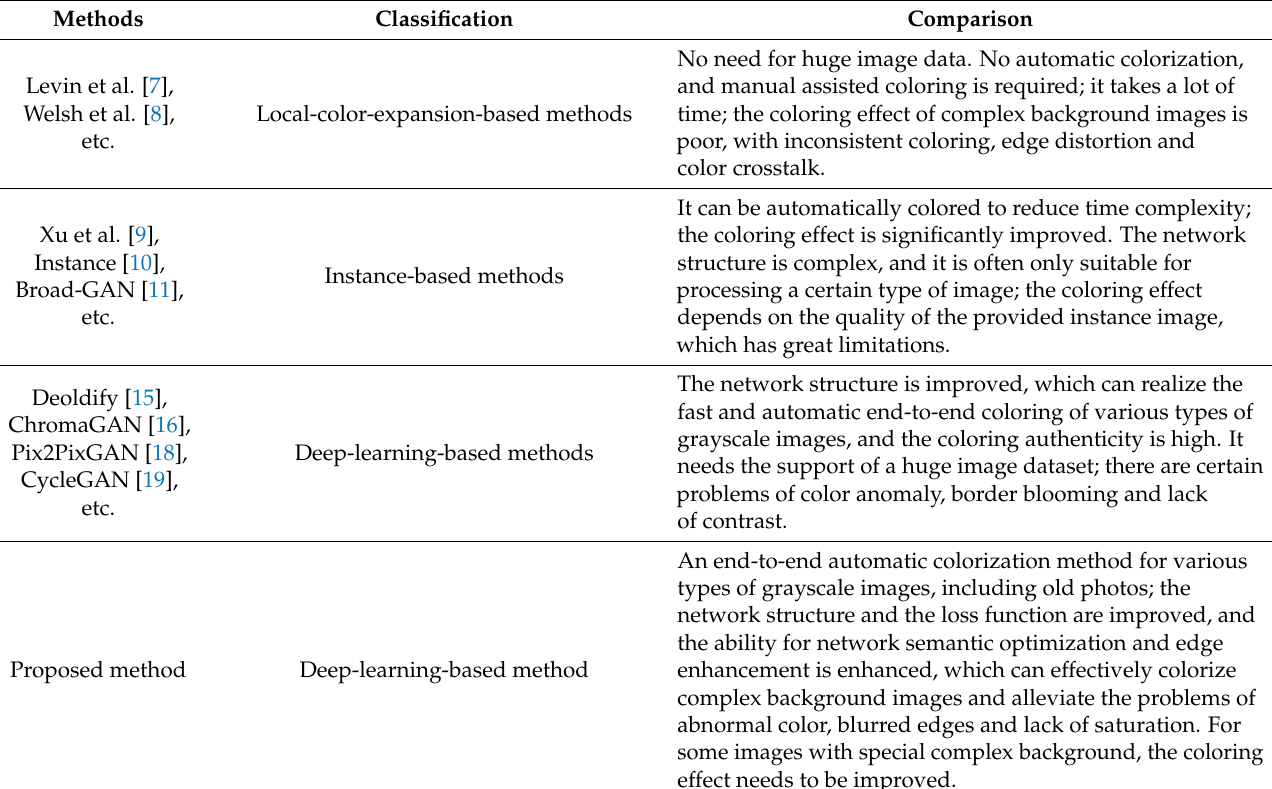
Table 1. The comparison of the proposed method with some other image colorization